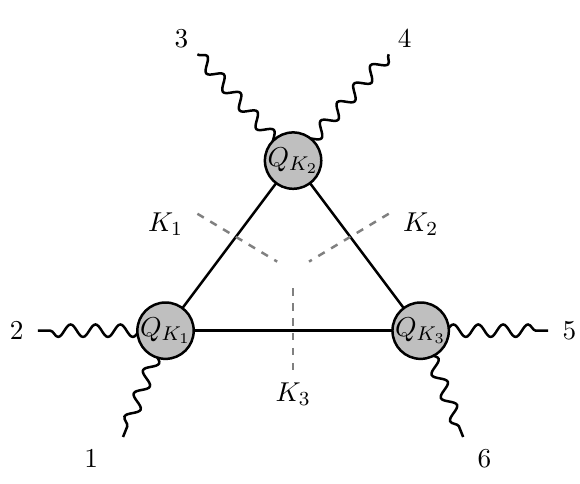
Figure 6 . Legs-(1,2), (3,4), and (5,6) are glued in three di(cid:11)erent corners with on-shell propagators, K 1 , K 2 and K 3 . When K 3 is identi(cid:12)ed with the loop momentum, the diagram gives the contribution as